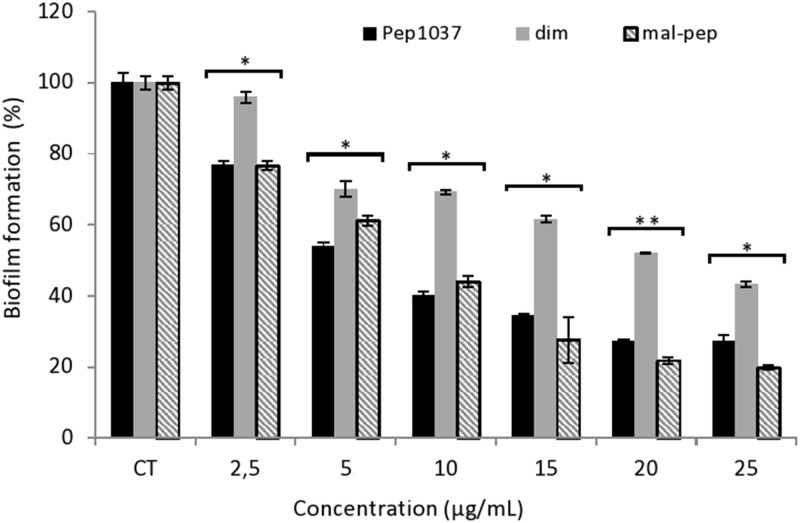
Effect of pep1037, cys-pep1037 dimer and mal-cys-pep1037 on the degradation of an established biofilm of a P. aeruginosa ATCC 27853 after 24 h.Error bars indicate the standard deviation of six replicates, and statistical significance was determined using ANOVA (*, P < 0.01; **, P < 0.001 versus the control, denoted CT).